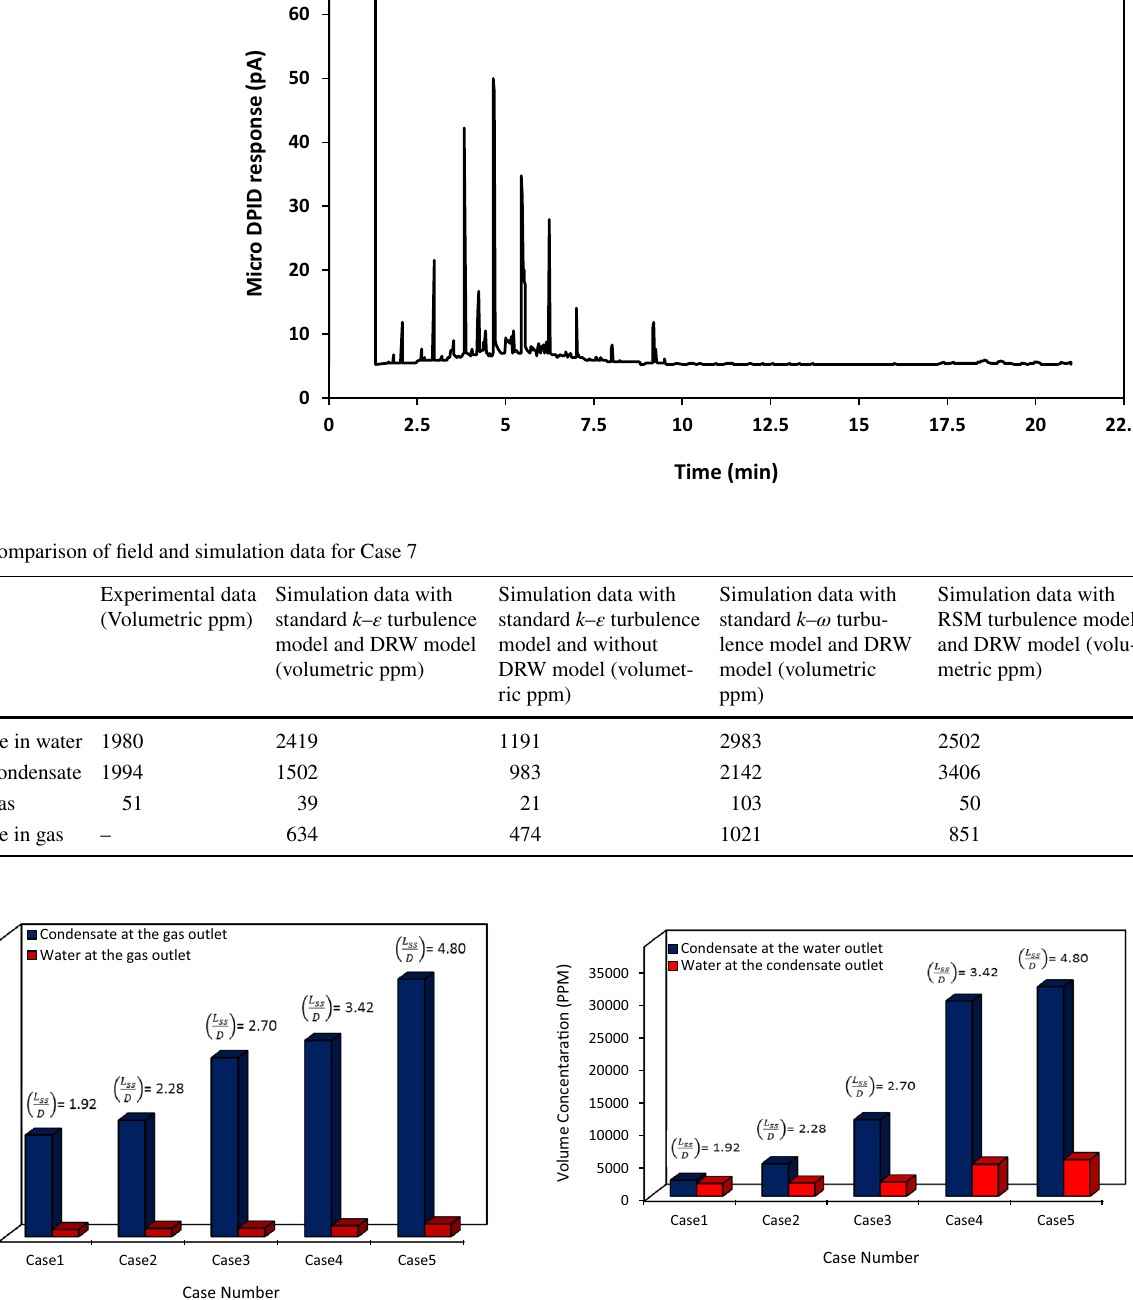
Fig. 9 Chromatograph response for the oily water sample